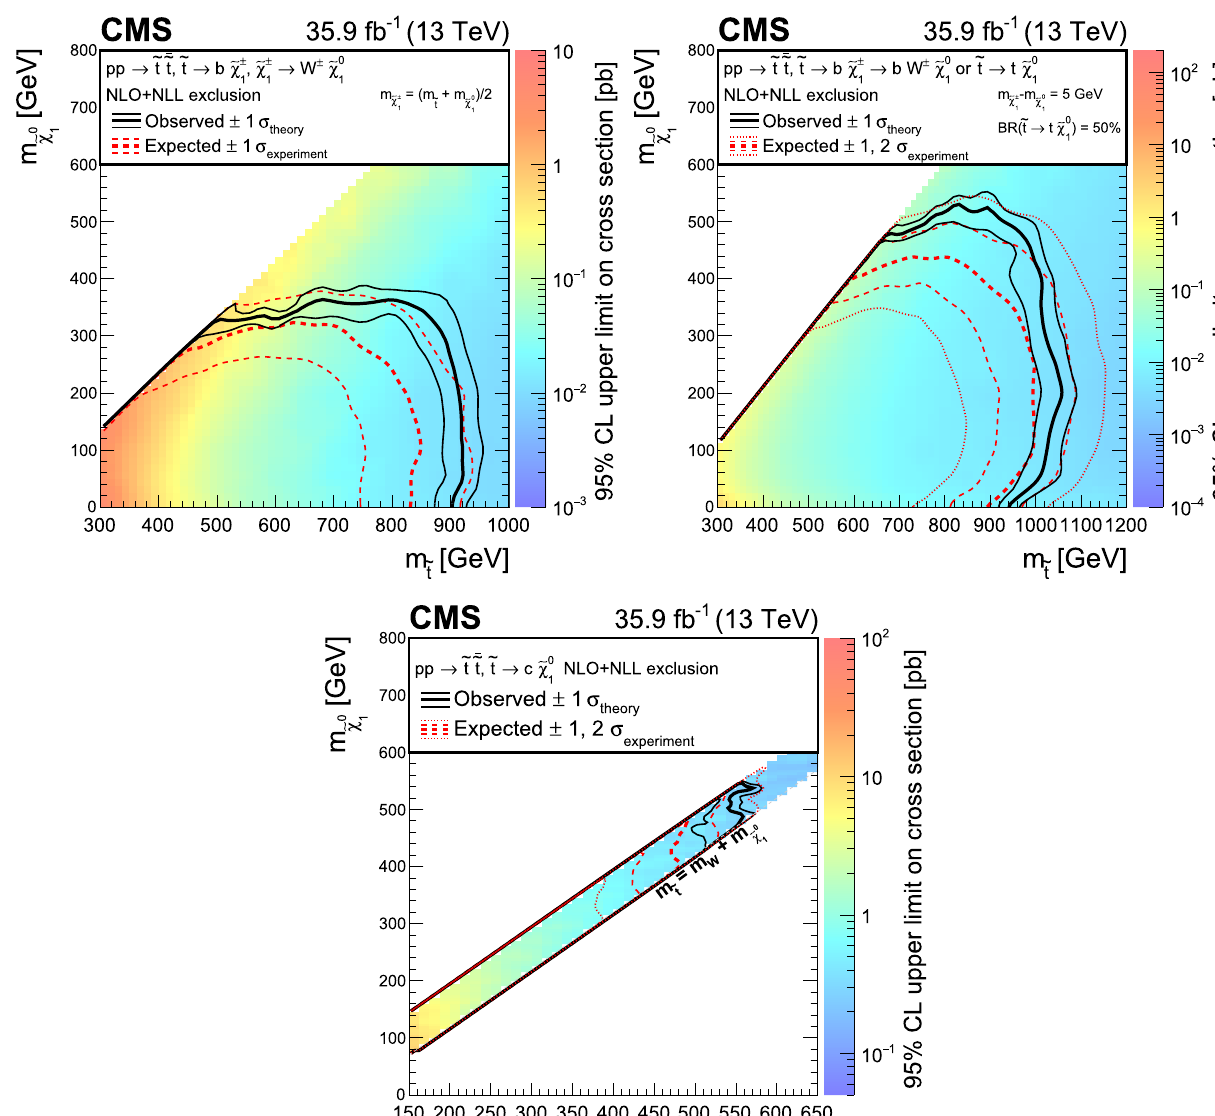
(cid:8) t → b (cid:8) χ + → W ∗+ (cid:8) χ 0 , (cid:8) χ + , is also considered, with the chargino mass (cid:3) (cid:2) 1 1 1 = 5GeV. Finally, we also consider a (cid:8) χ ± , (cid:8) χ 0 chosen such that Δ m 1 1 compressed scenario (below) where pp → (cid:8) t (cid:8) t → cc (cid:8) χ 0 enclosed by the thick black curve represents the observed exclusion region, while the dashed red lines indicate the expected limits and their ± 1 standard deviation ranges. The thin black lines show the effect of and 1 the theoretical uncertainties on the signal cross